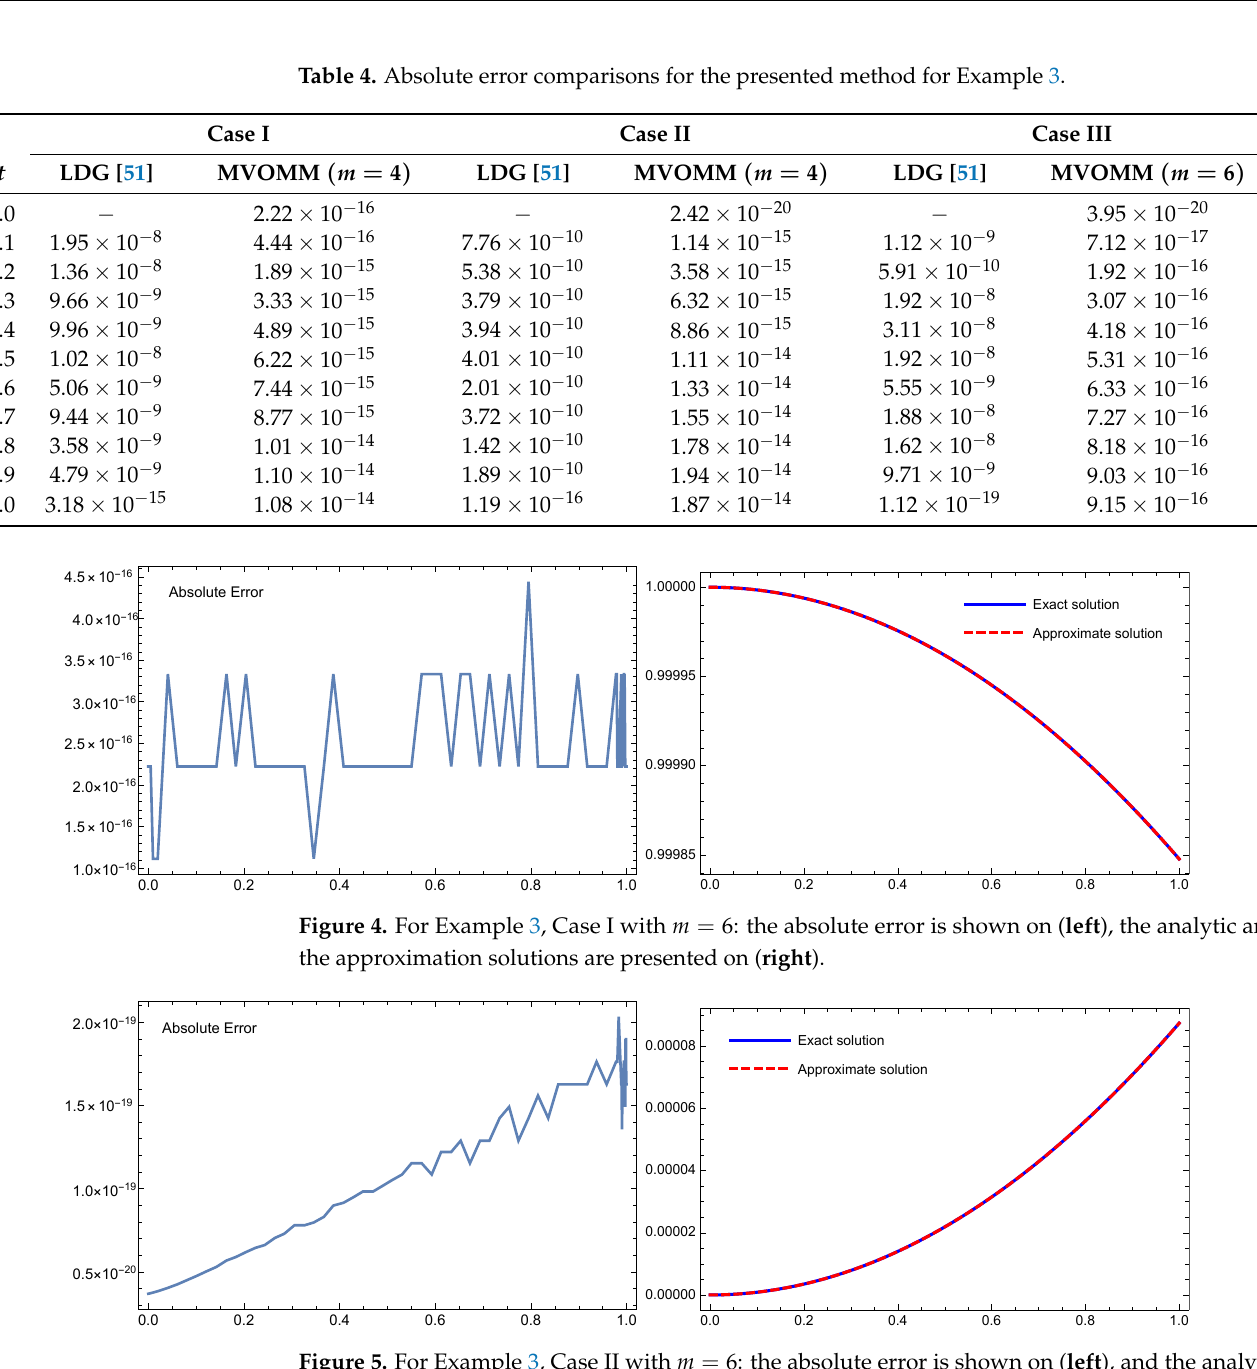
Figure 5. For Example 3, Case II with m = 6: the absolute error is shown on ( left ), and the analytic and an approximation solutions are presented on ( right